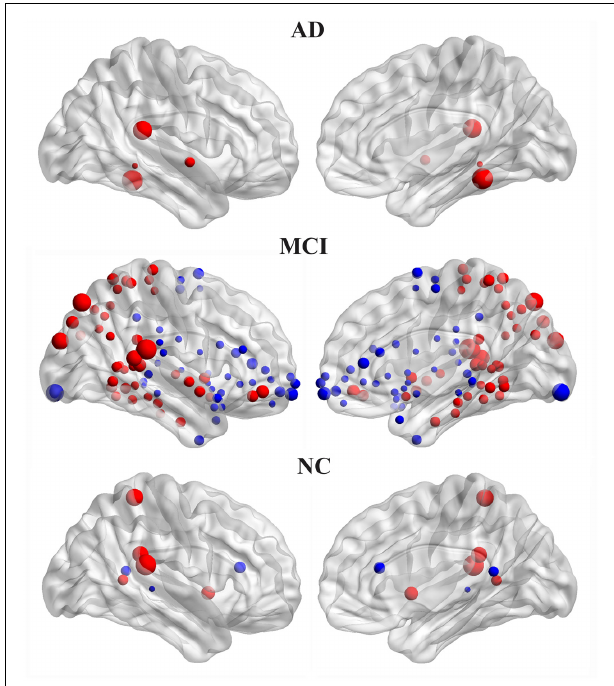
FIGURE 4 | Three-dimensional representations of the significant between-hemisphere differences in nodal efficiency (FDR-corrected P < 0.05) in the AD, MCI and NC groups. The nodes shown in red represent the significantly rightward asymmetric nodes, and the nodes in blue represent significantly leftward asymmetric regions. The node size represents the absolute value of the difference between two hemispheres in mean node efficiency